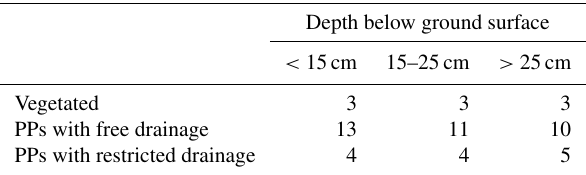
Figure 6. Mean θ measured underneath vegetated surfaces (top), PPs with free drainage (middle) and PPs with restricted drainage (bottom). The grey background indicates the winter half year. Table 2. Number of sensors included within each category in Fig. 6.